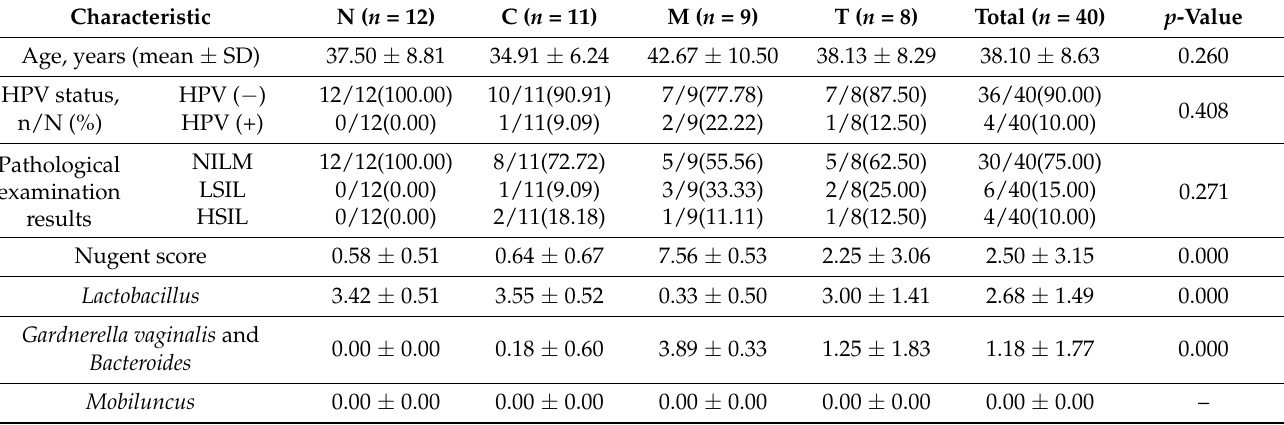
Table 1. Summary of the available characteristics of patients in the four